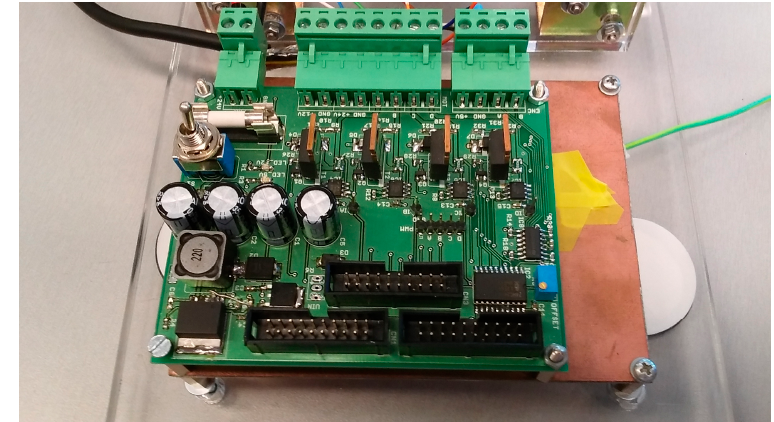
Table 1. The comparison of current transients obtained from simulation and measurements is provided in Figure 4, showing a very satisfying agreement.